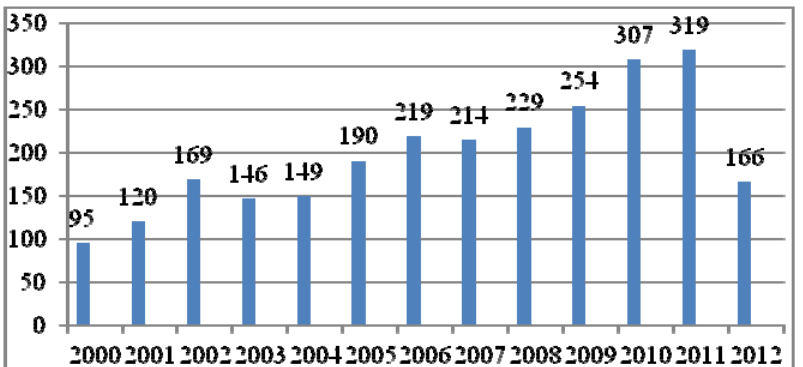
Figure 3. Number of publications in the last twelve years involving